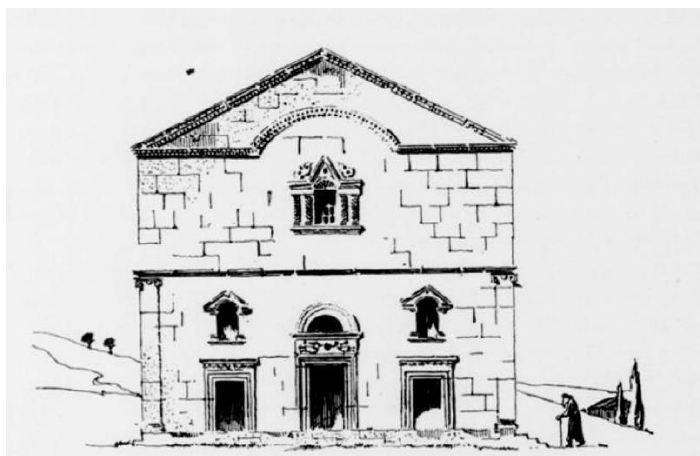
Figure 6. Synagogue in ed-Dikke, theoretical reconstruction by (Kohl and Watzinger 1916, p. 124).